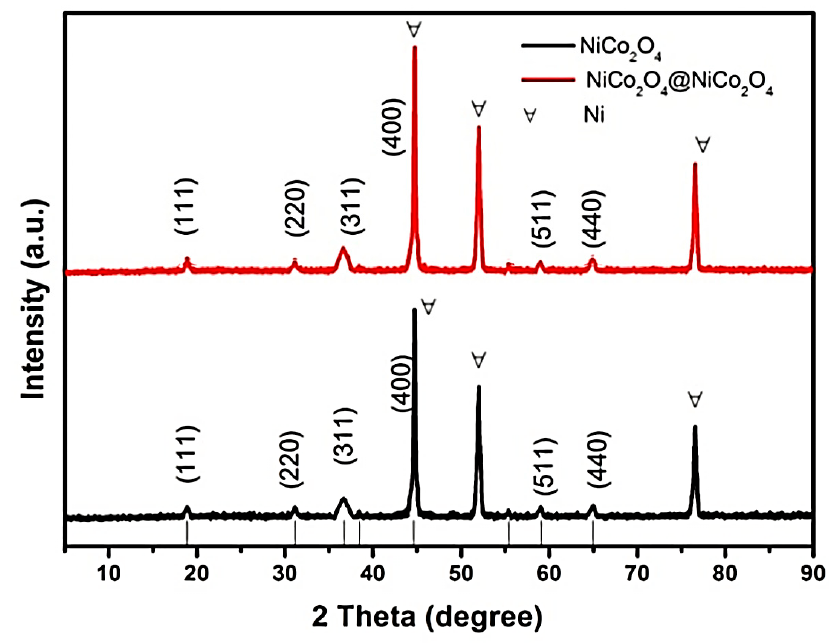
Figure 2. XRD analysis of NiCo 2 O 4 @NiCo 2 O 4 nanoflake and bare NiCo 2 O 4 electrodes. Morphologies of bare NiCo-layered double hydroxides (LDH) before annealing, plain NiCo 2 O